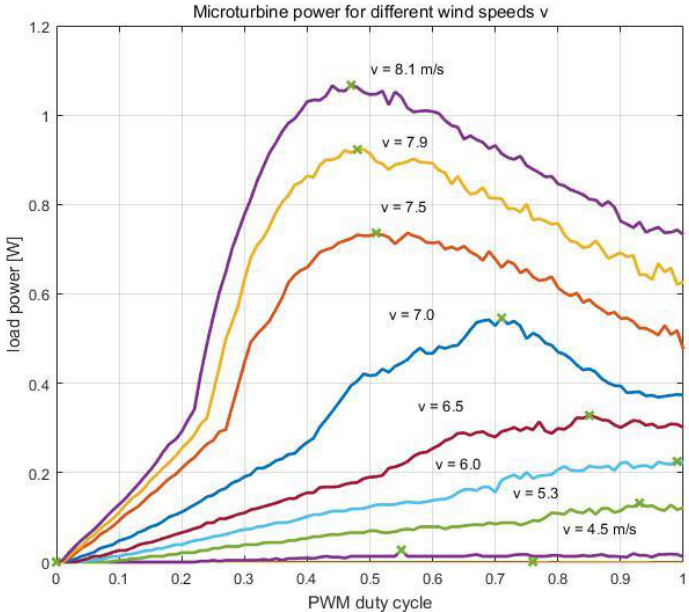
Figure 15. The power generated by a wind turbine with adjustable pitch, as a function of the duty cycle, for different wind